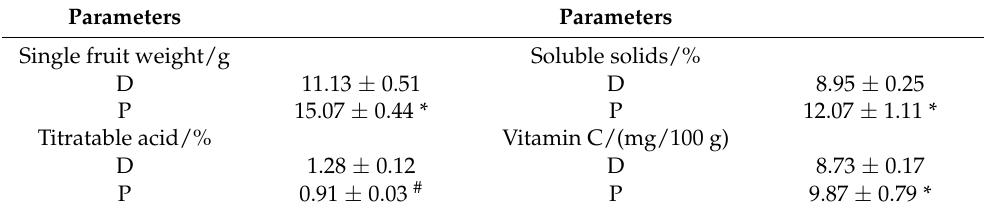
Table 2. Effects of prochloraz on the quality of fruits of decline-diseased